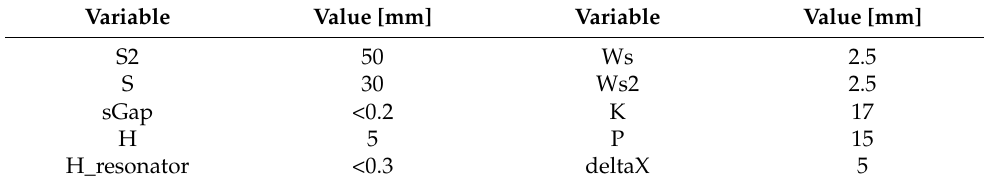
Table 4. Ecoflex EDM tag